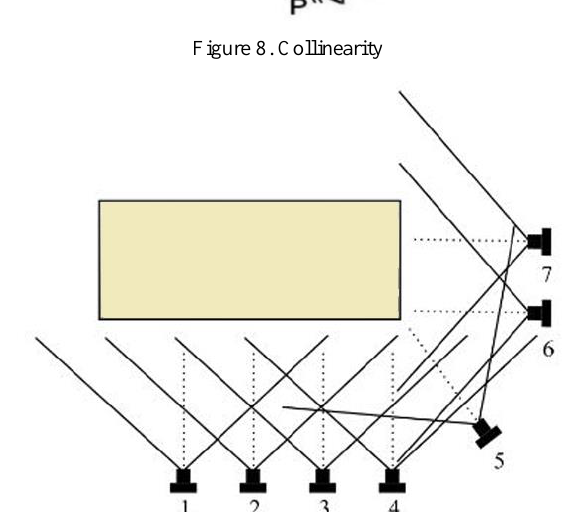
Figure 8. Collinearity